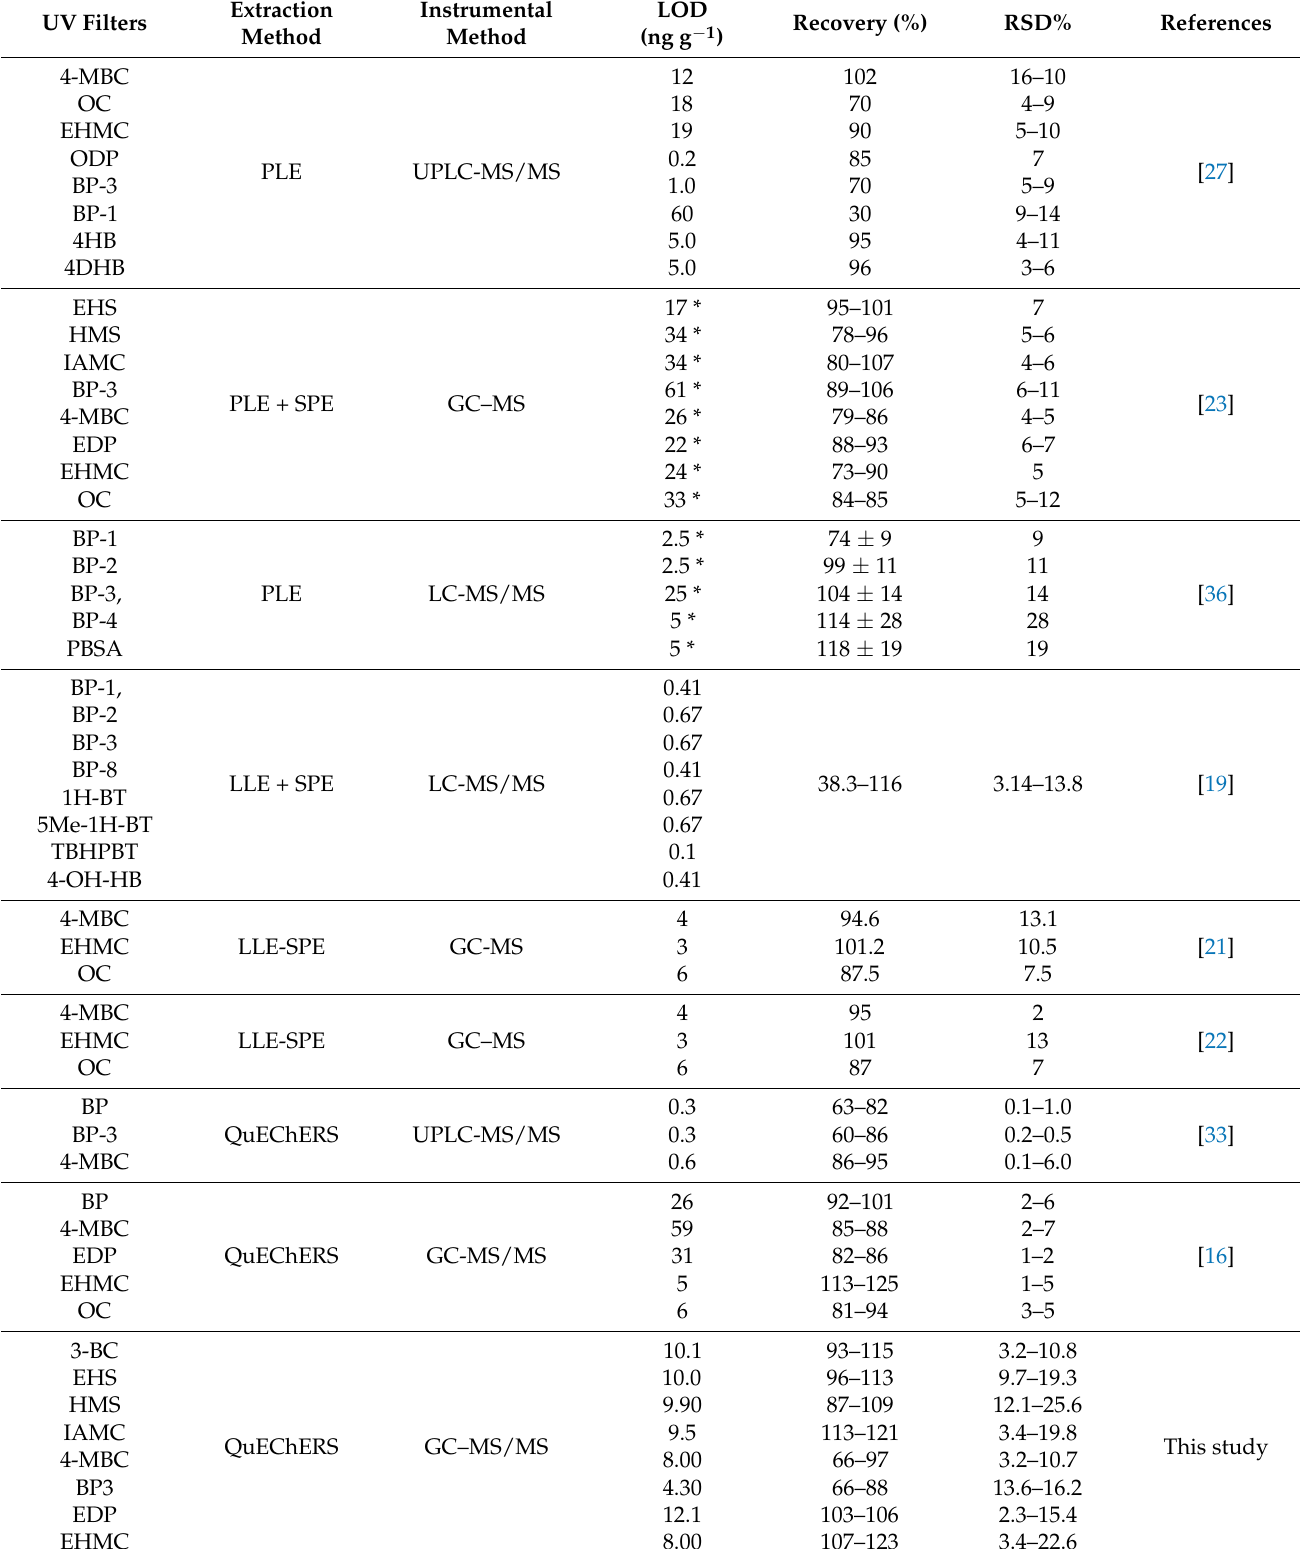
Table 7. Comparison of QuEChERS method with previous microextraction studies in sludge